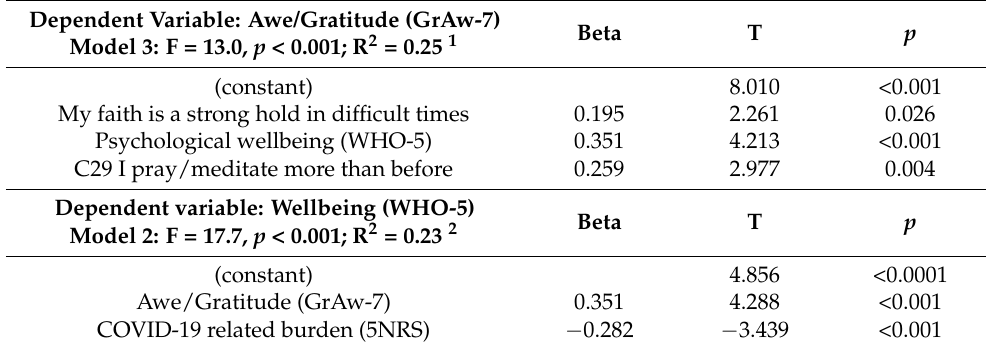
Table 5. Predictors of Awe/Gratitude and Wellbeing,